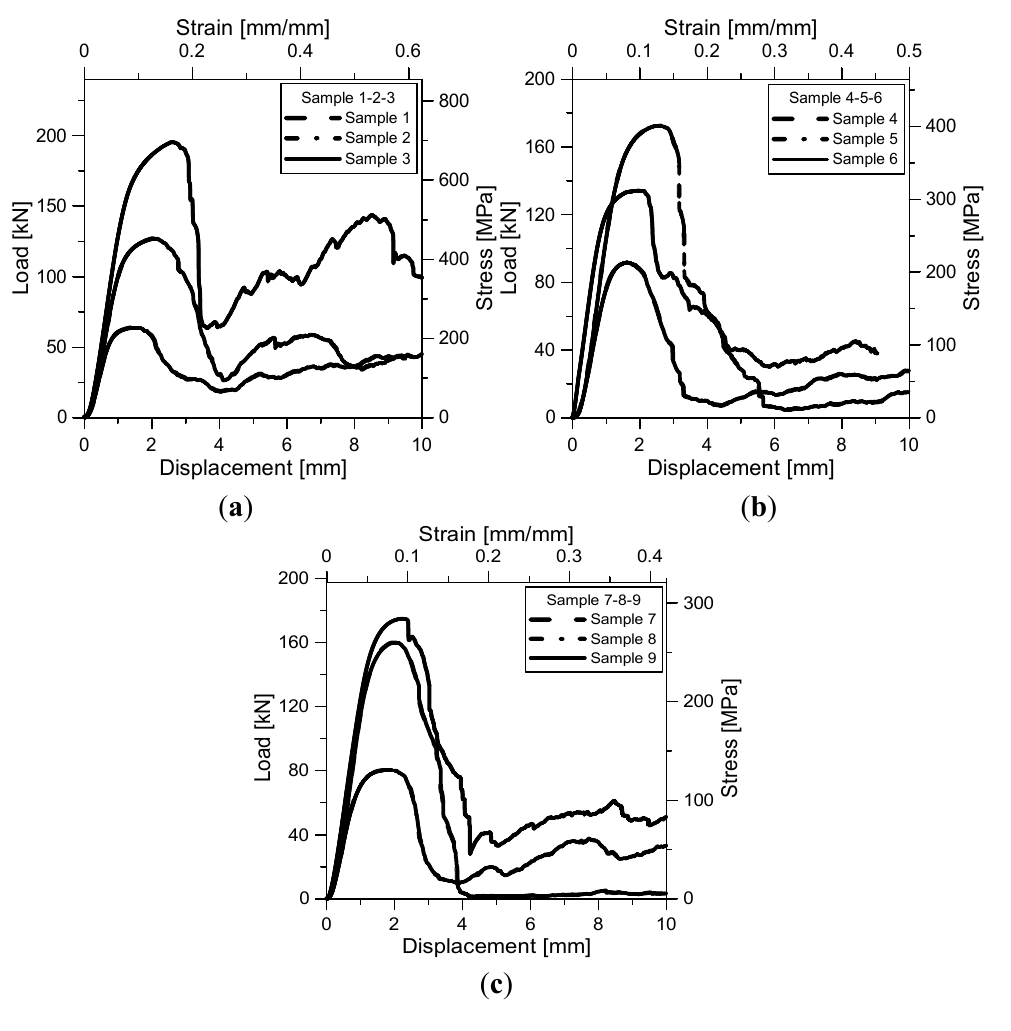
Figure 5. Load-displacement/stress strain curves for L = 2 mm sample ( a ); L = 2.5 mm sample ( b ); and L = 3 mm sample ( c